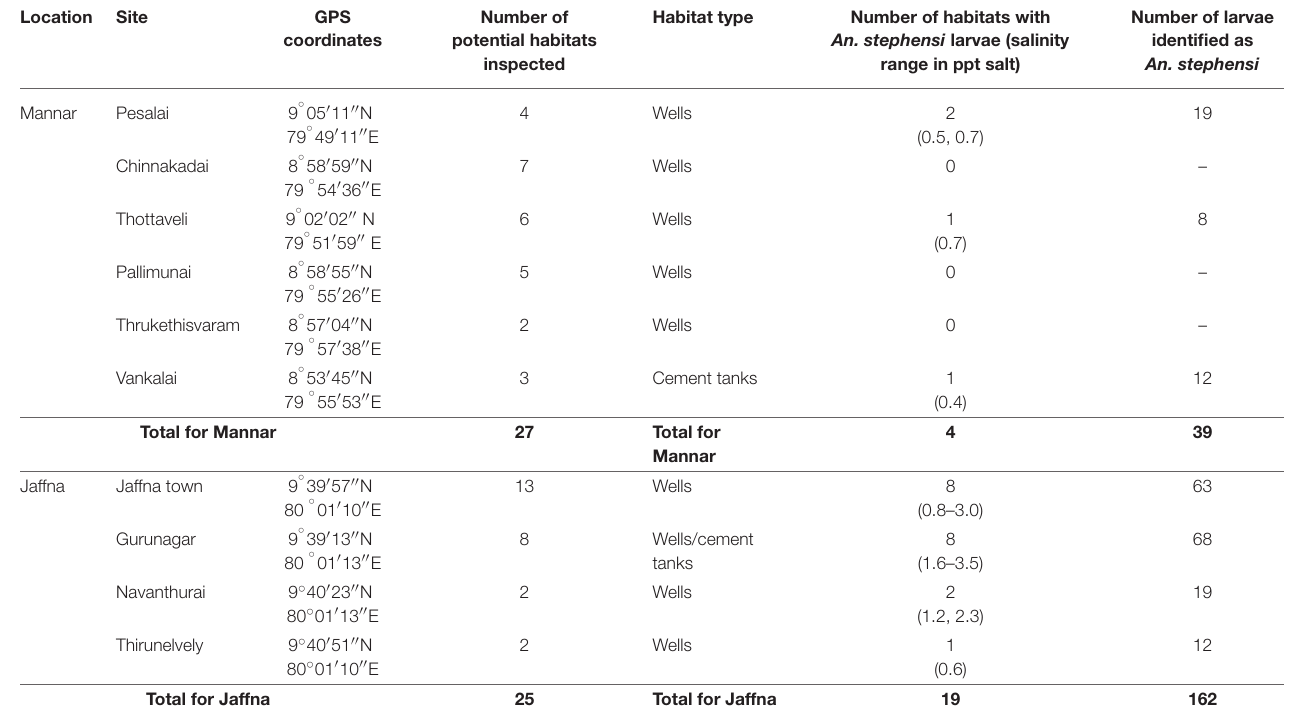
TABLE 1 | Anopheles stephensi presence and salinity in surveyed larval habitats in Mannar and Jaffna. Location